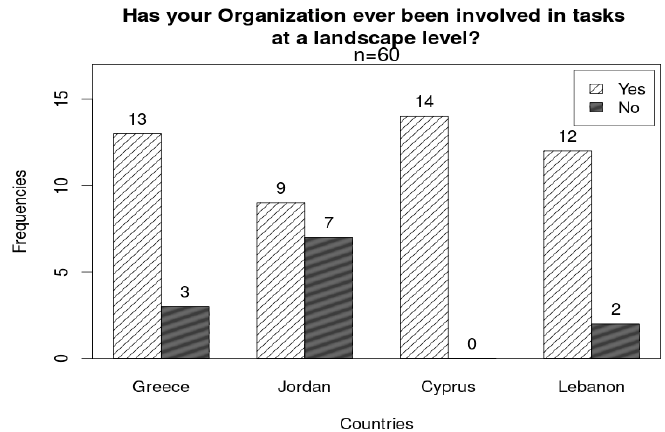
Figure 3. Frequencies of answers to the question “Has your Organization ever been involved in tasks at a landscape level (management, planning, recording or protection)?” by country of residence.